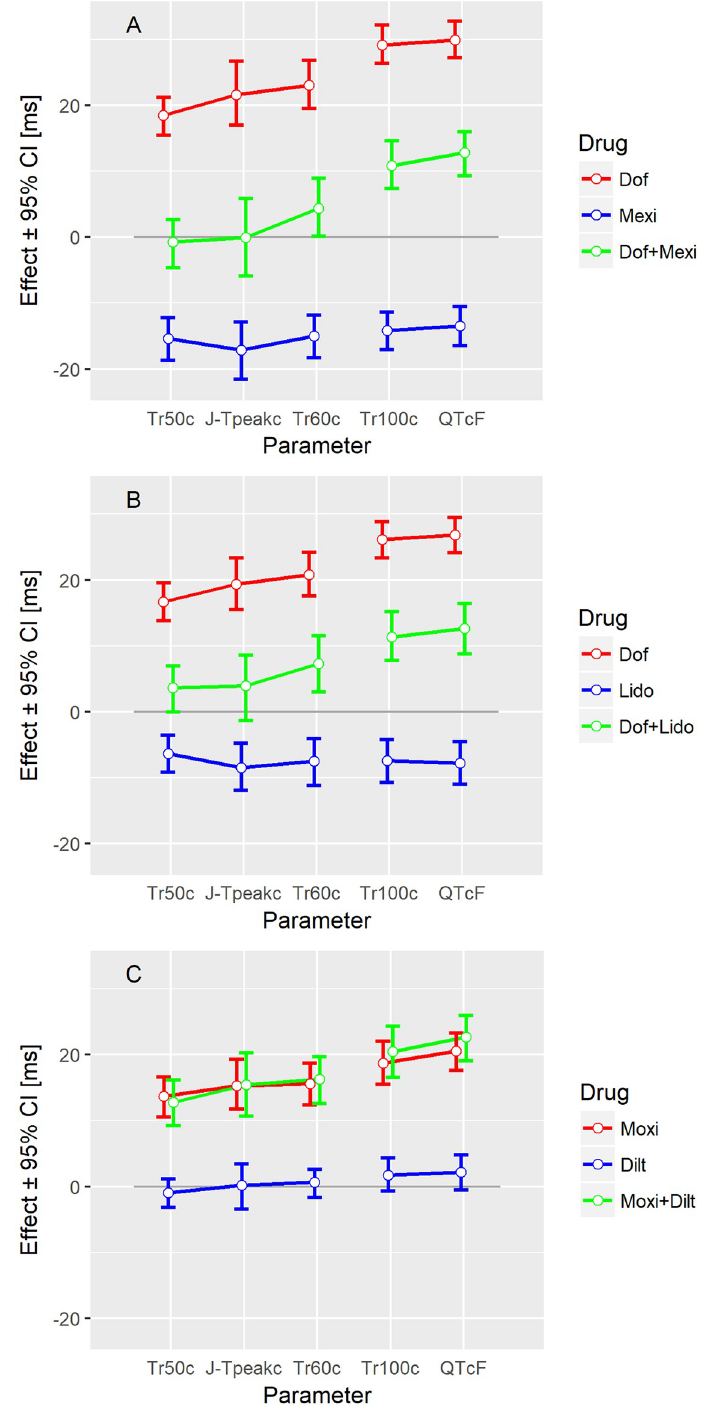
Fig 7. Drug effects on selected parameters in Study B. The drug effects on J-T peak c are between the effects of the 50% and 60% T vector trajectory quantiles (Tr50c and Tr60c) but have larger confidence intervals. The effects on the 100% T vector trajectory quantile (Tr100c) are comparable to the effects on